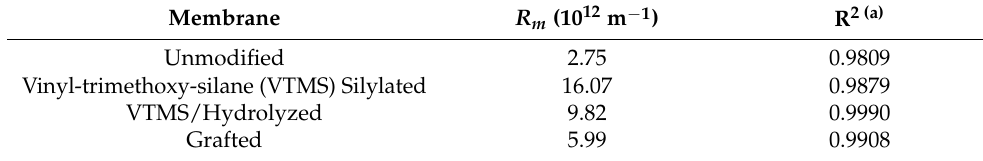
Table 1. Hydraulic resistance of unmodified and modified zirconia Carbosep M1 membranes.